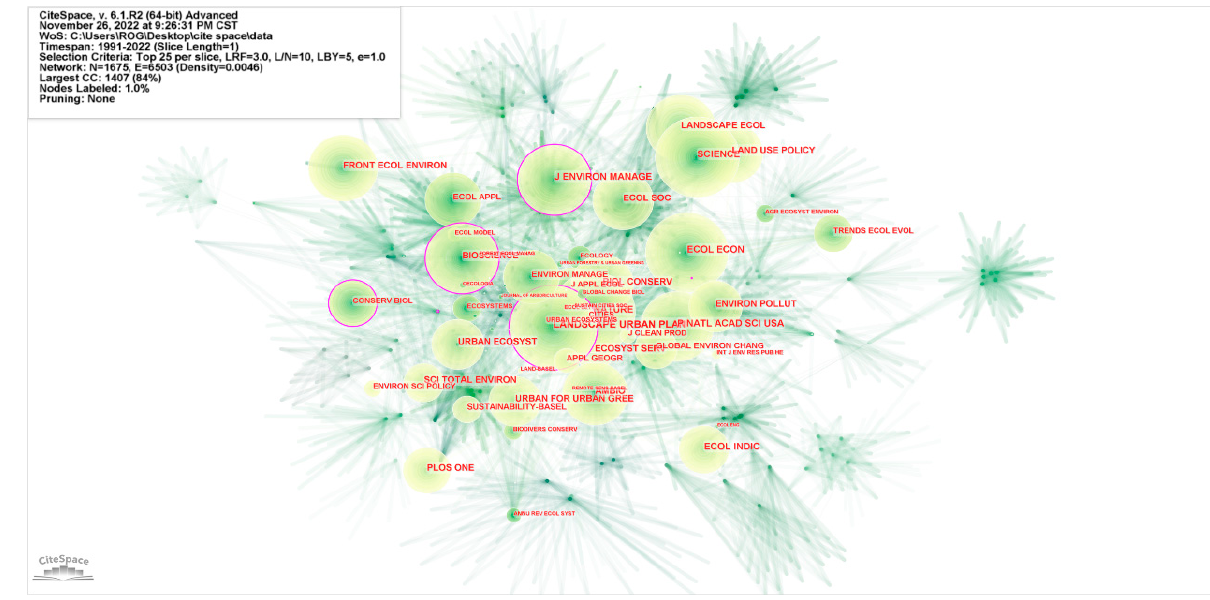
Figure 3. Knowledge map of co-journals of papers published on UES from 1991–2022. Table 1. Major research journals in the field of urban ecosystem services from 1991 – 2022.